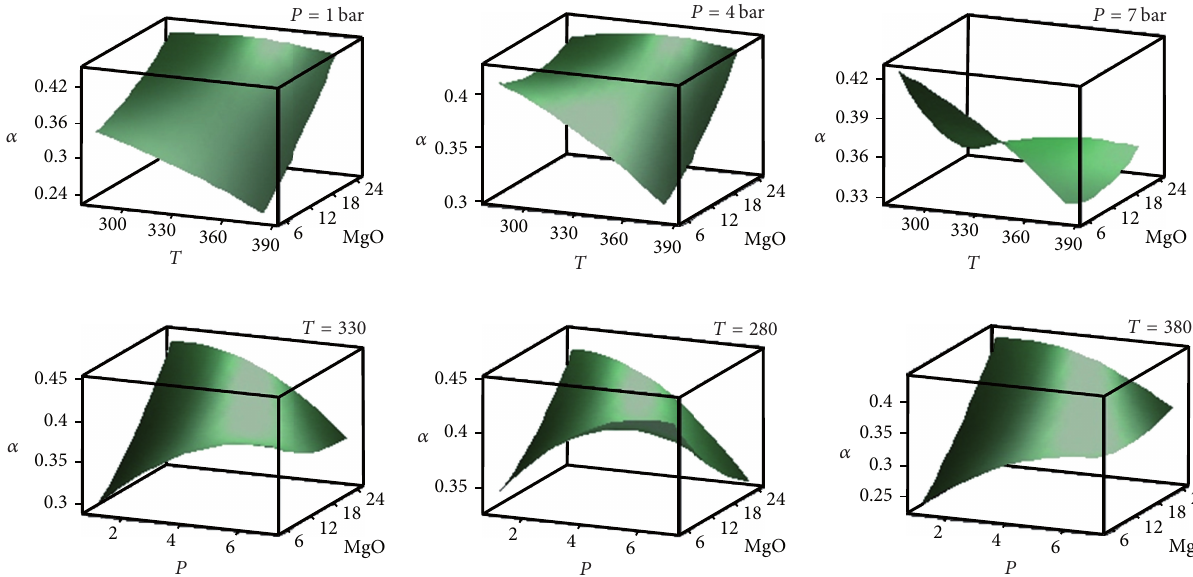
F 6: Effect of temperature, pressure, and structural promoter on chain growth probability, approaches to a maximum as pressure increases. MgO increases in low to moderate pressures. 𝛼𝛼 T 4: Optimum conditions according to the nonlinear programming approach. Type of